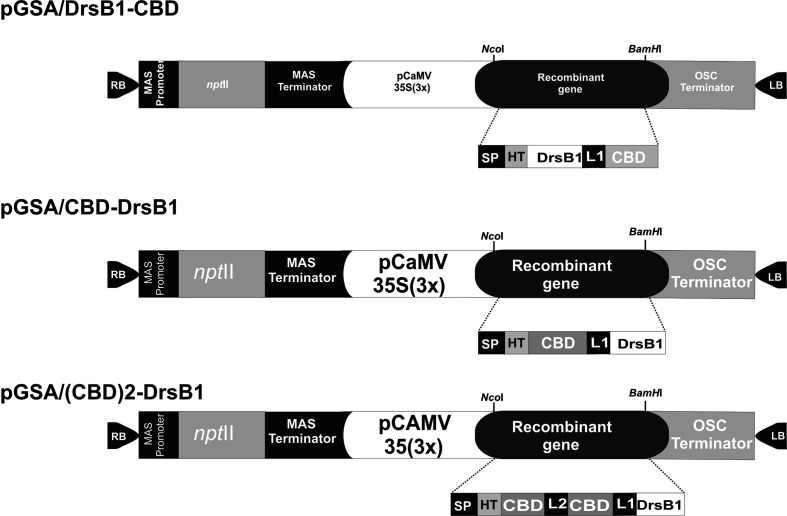
Schematic representation of the three genetic constructs used for Agrobacterium-mediated transformation. MAS, mannopine synthase; npt II: neomycin phosphotransferase II; CaMV35S(3×) cauliflower mosaic virus 35S promoter; OSC, octopine synthase; SP, Avr4 signal peptide; HIS, RGS histidine tag; DrsB1, dermaseptin B1; CBD, carbohydrate binding domain from Avr4 effector protein; L1, helix-forming linker (EAAAK)4; L2, linker sequence from Caenorhabditis elegans chitinase (CCD73759) gene; RB and LB, right and left borders of Agrobacterium T-DNA region. Two CBDs are fused together by a linker sequence from Caenorhabditis elegans chitinase (CCD73759) gene.